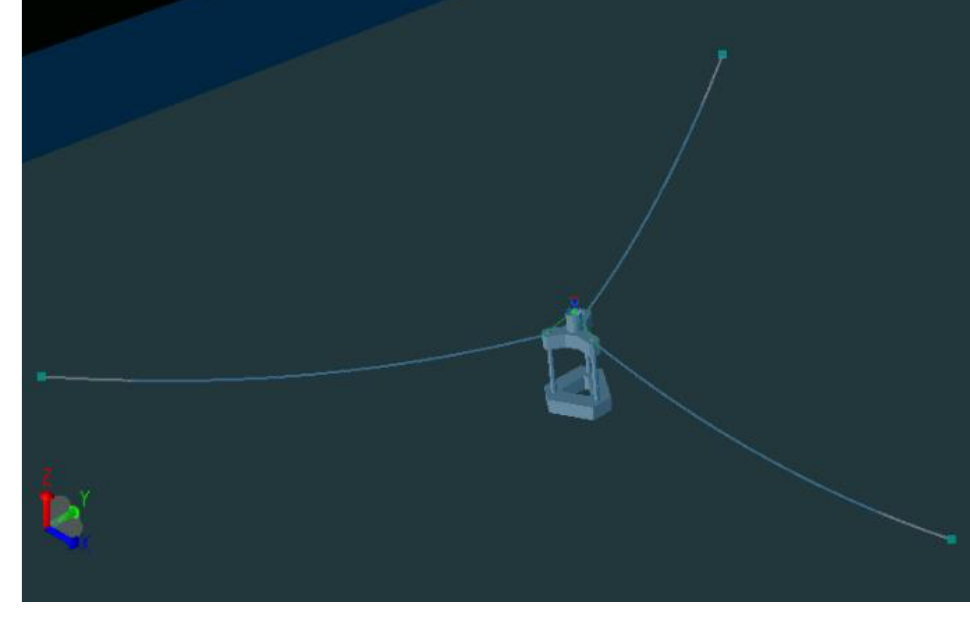
Figure 3. Coupled model in SESAM DeepC ®